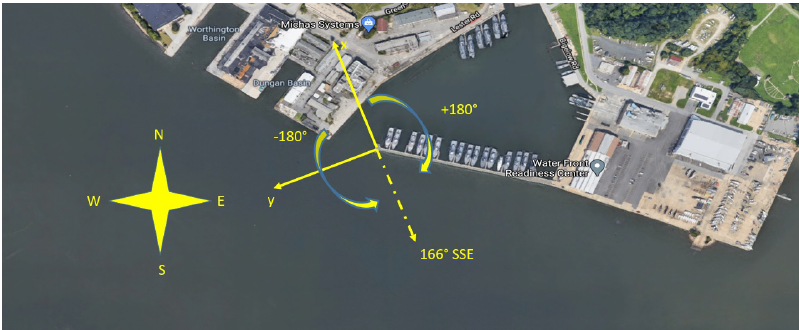
Figure 3. Sensor orientation and wind velocity angle readings compared to compass